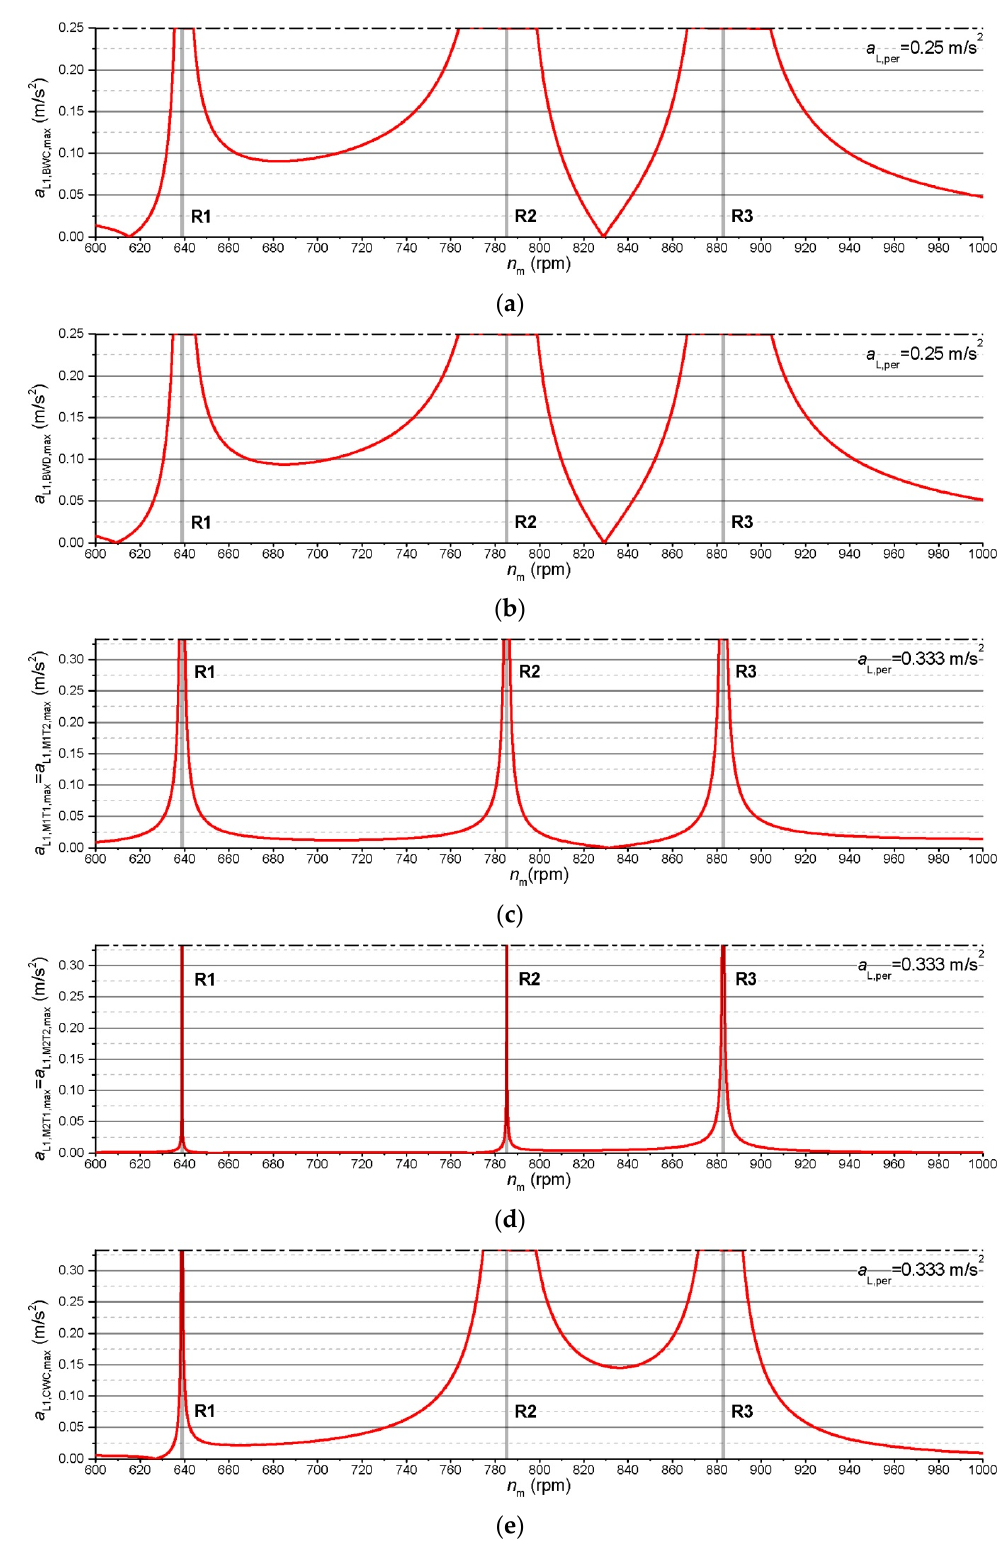
Figure 5. Response to the first harmonic of excitation—maximal lateral accelerations of the referent points of the slewing superstructure: ( a ) BWC; ( b ) BWD; ( c ) M1T1 and M1T2; ( d ) M2T1 and M2T2; ( e ) CWC.